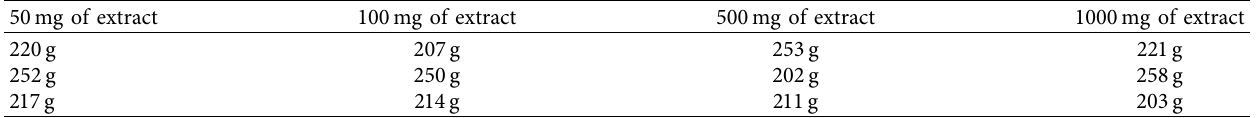
Table 1: Rats’ weights in each tested dose in the LD